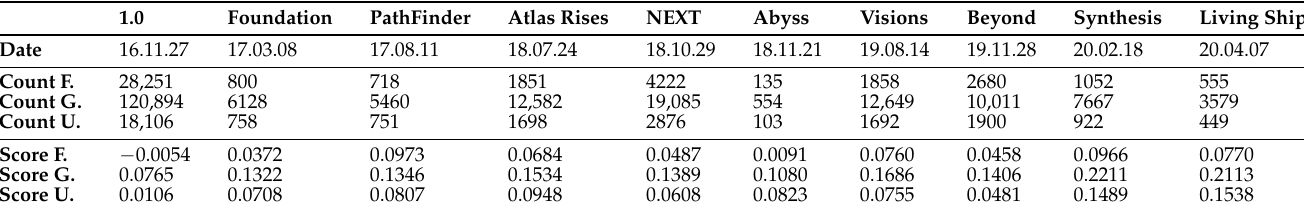
Table 4. Playability score changes through major updates.